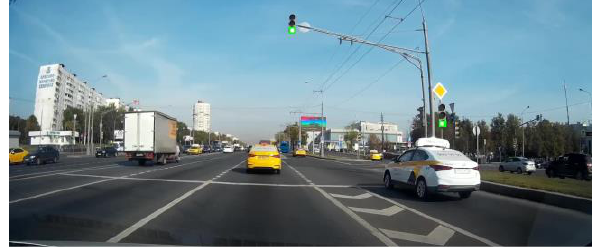
Figure 3 . Traffic lights found in the road